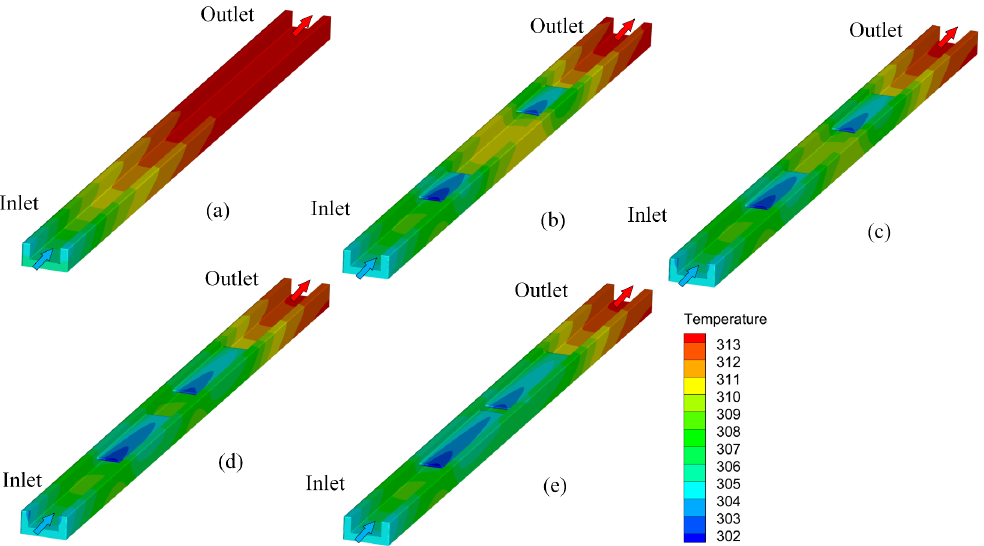
Figure 10. Temperature diagram of solid region at the inlet velocity of 1.5 m/s; ( a ) Case 0, ( b ) Case 1, ( c ) Case 2, ( d ) Case 3, and ( e ) Case 4.